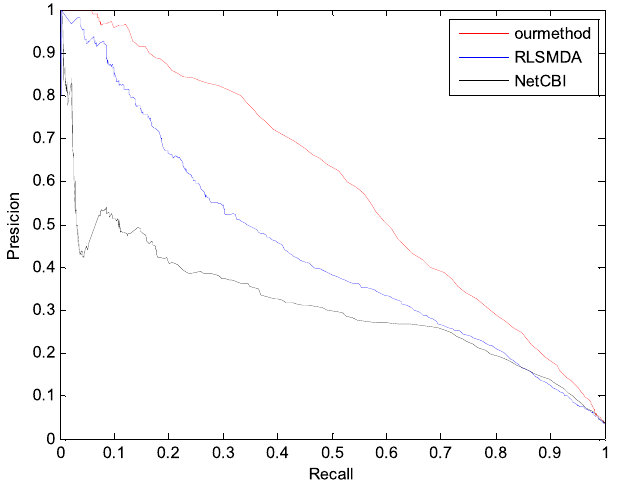
Figure 5. The Precision-recall curves of RLSMDA, NetCBI and GSTRW.